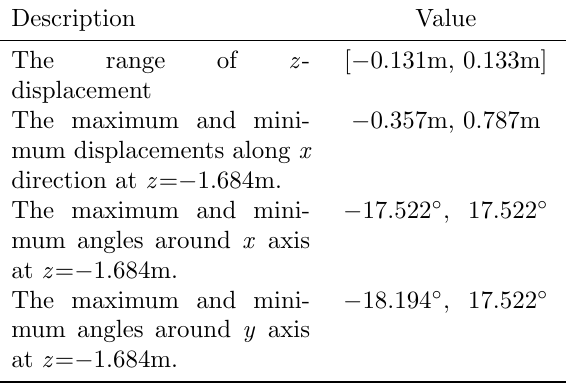
Figure 7: The kinematics and dynamics results of the GHMT obtained from developed model 5.2 Dynamic simulation with ADAMS